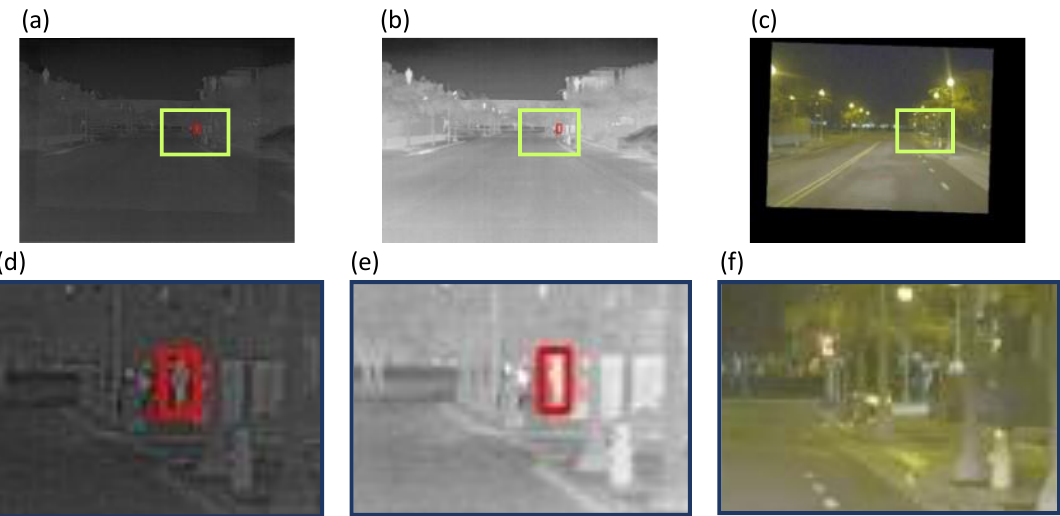
Figure 13. Image FLIR_07989: example of the bounding box size effect on IoU score. Despite the correct detection and classification, this image’s IoU score is 71%. A subsection marked in network classification of the RXD Anomaly Fusion image ( a ), GT image ( b ), and original RGB image ( c ), with light green boxes that are zoomed in to the region of interest, shown in images ( d , e , f ), respectively.